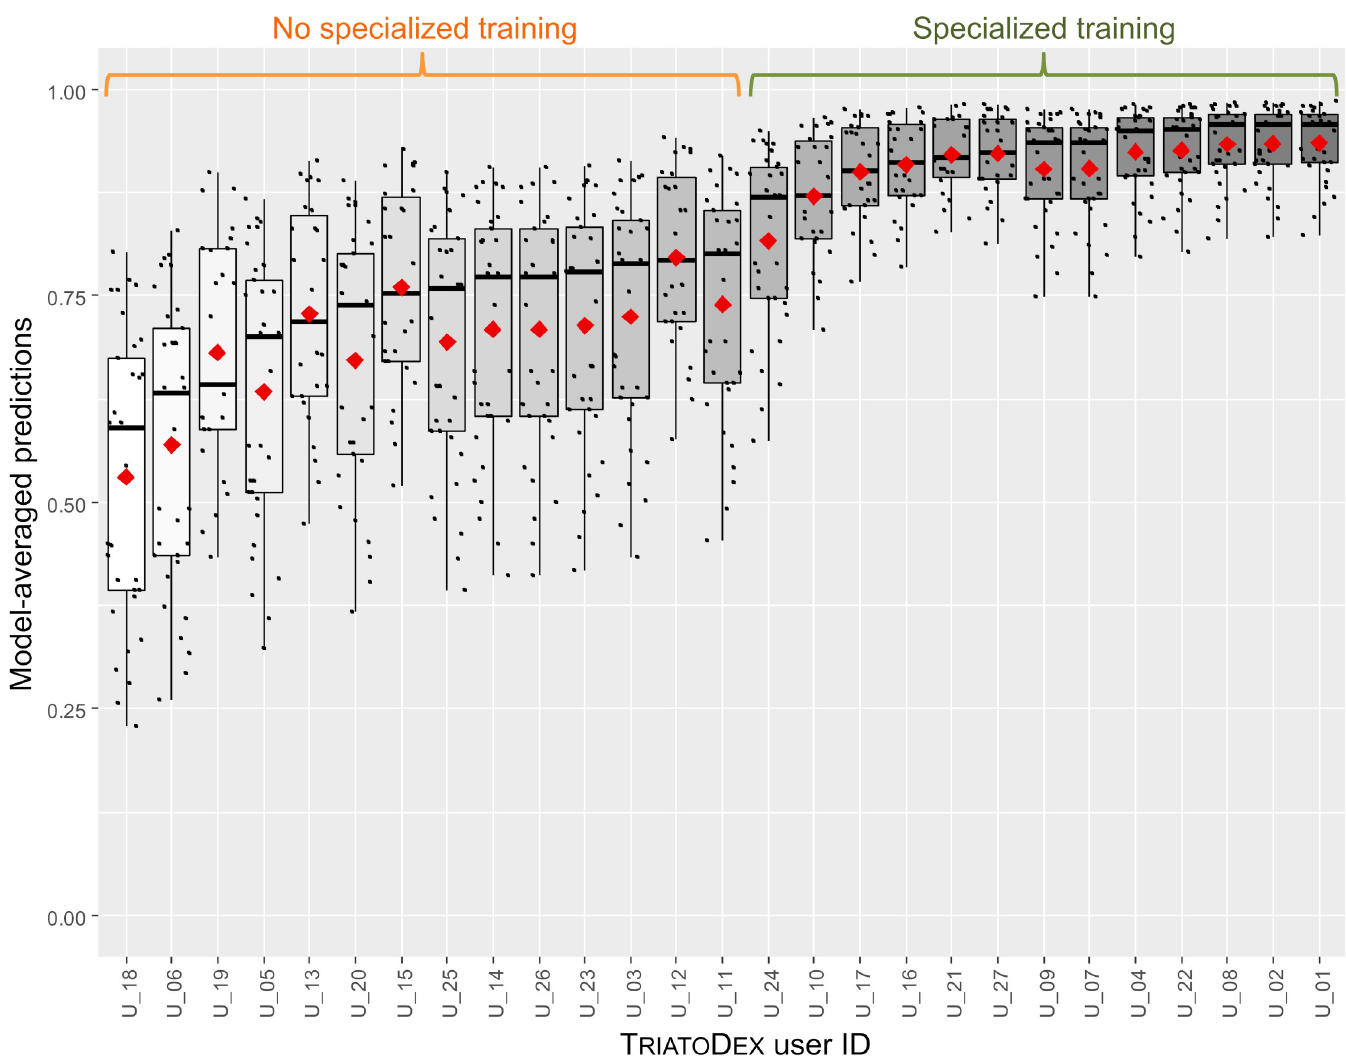
Fig 2. Predicted proportions of correct triatomine-bug identification (33 species) by 27 T RIATO D EX users. Predictions are derived using Akaike weights from a set of 512 generalized linear mixed models; note that users with specialized training in triatomine-bug taxonomy did clearly better than those without. Black dots are user- and species-specific predictions; boxplots show medians (thick horizontal lines), quartiles (boxes), and values that fall within 1.5 times the interquartile range (whiskers); red diamonds are means.